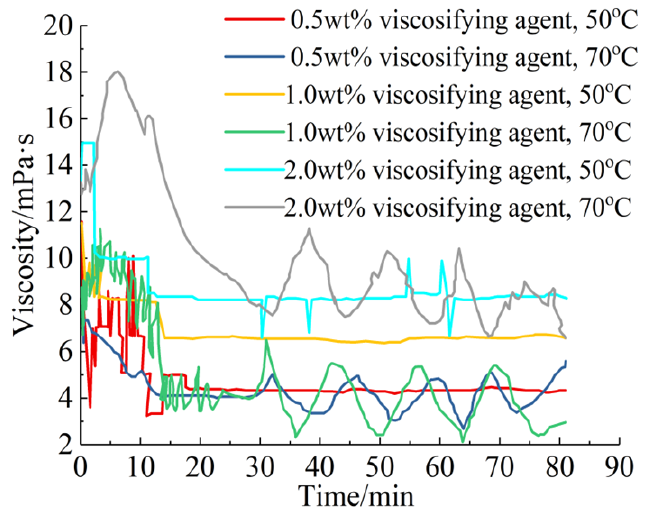
Figure 4. Rheology of slickwater fracturing fluid at a shear rate of 170 s − 1 . Temperature had a significant effect on the viscosity of the slickwater fracturing fluid, and the viscosity at 50 ◦ C was generally higher than that at 70 ◦ C when the viscosifying agent was 0.5 wt% and 1.0 wt%. However, when the viscosifying agent was 2.0 wt%, the viscosity at 50 ◦ C seemed more stable than that at 70 ◦ C. When the temperature was 70 ◦ C, the viscosity fluctuated greatly, but the fluctuation range basically did not change with time. At 70 ◦ C, the viscosity of the slickwater fracturing fluid was basically similar when the viscosifying agent concentrations were 0.5 wt% and 1.0 wt%; however, the viscosity increased significantly when the viscosifying agent concentration was 2.0 wt%. At 50 ◦ C, the concentration of viscosifying agent had a significant influence on the viscosity, and the viscosity increased significantly with increasing viscosifying agent concentration.